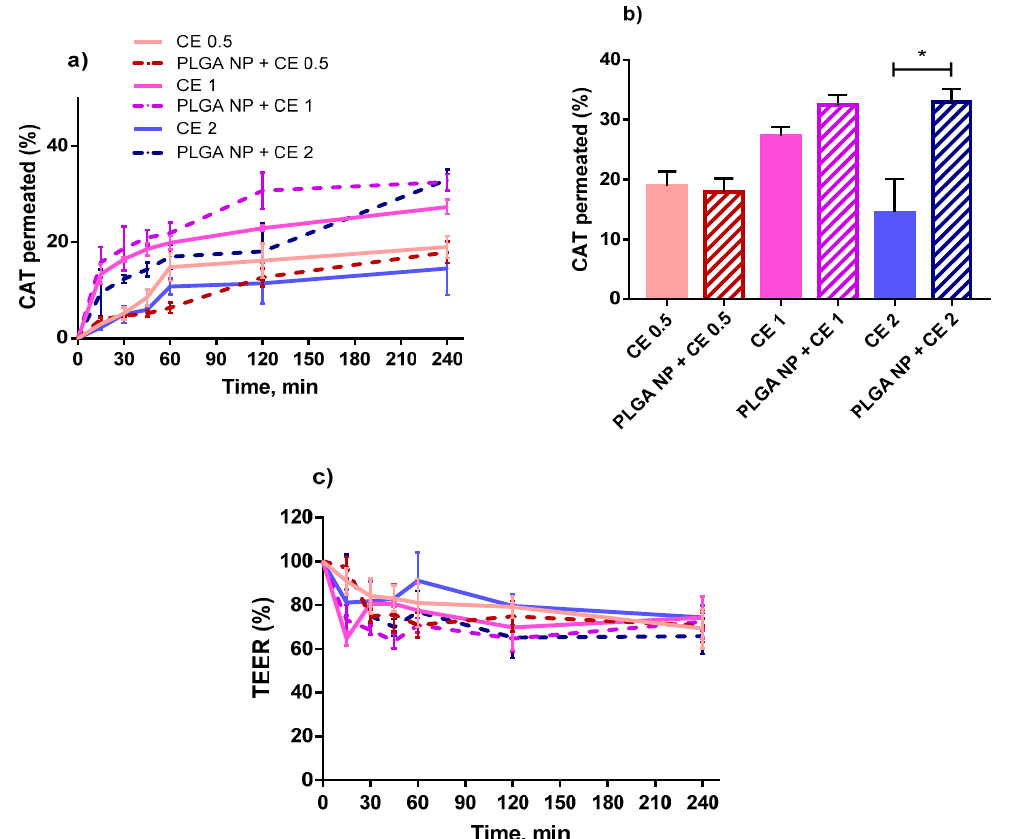
Figure 4. Percentage of catechin (CAT) permeated ( a ) from non-encapsulated CE or CE-loaded PLGA NP at the CE polyphenol concentrations of 0.5, 1, or 2 µg/mL GAE and corresponding transepithelial electrical resistance (TEER) values ( c ) during the permeability study in the triple-cell co-culture model (Caco-2/HT29-MTX/Raji B). ( b ) represents the % CAT permeated after 240 min. *, significantly different from each other.